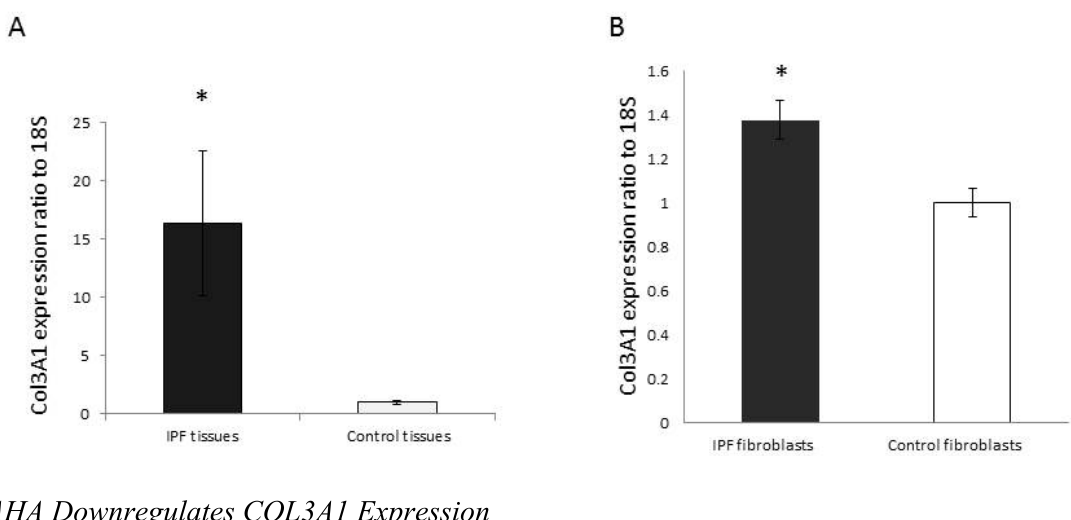
Figure 1. Idiopathic pulmonary fibrosis (IPF) lung tissues ( A ) and primary fibroblasts ( B